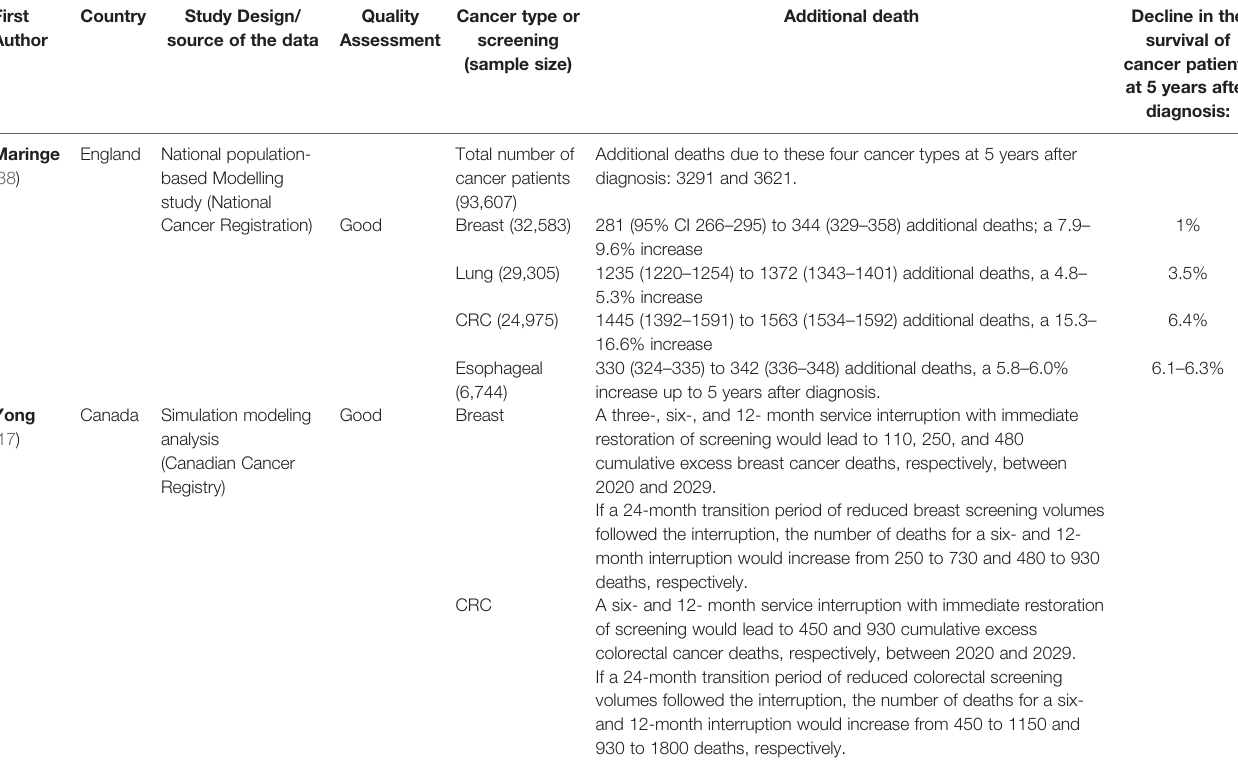
TABLE 4 | Impact of COVID-19 on mortality rates and YLLs in cancer